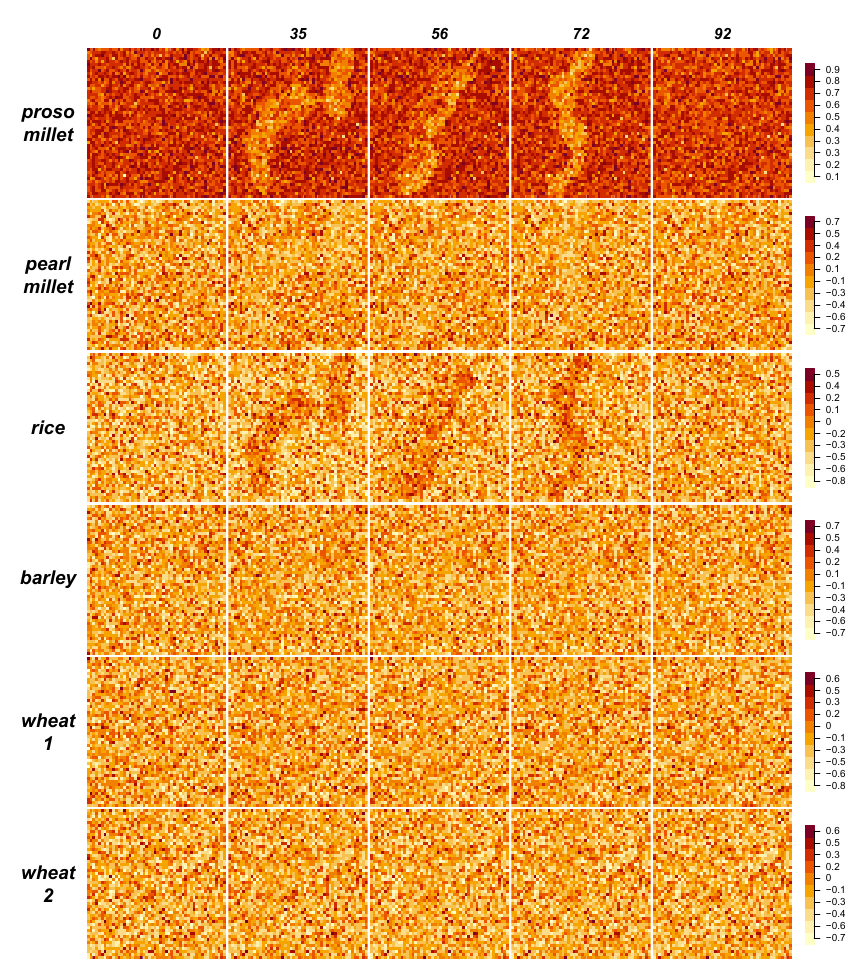
Figure 11. Correlations between crop frequencies and summed total yield per crop in each land unit of the five terrains, as generated in experiment 5. Color saturation gradient represents the interval between crop-wise minimum and maximum correlation